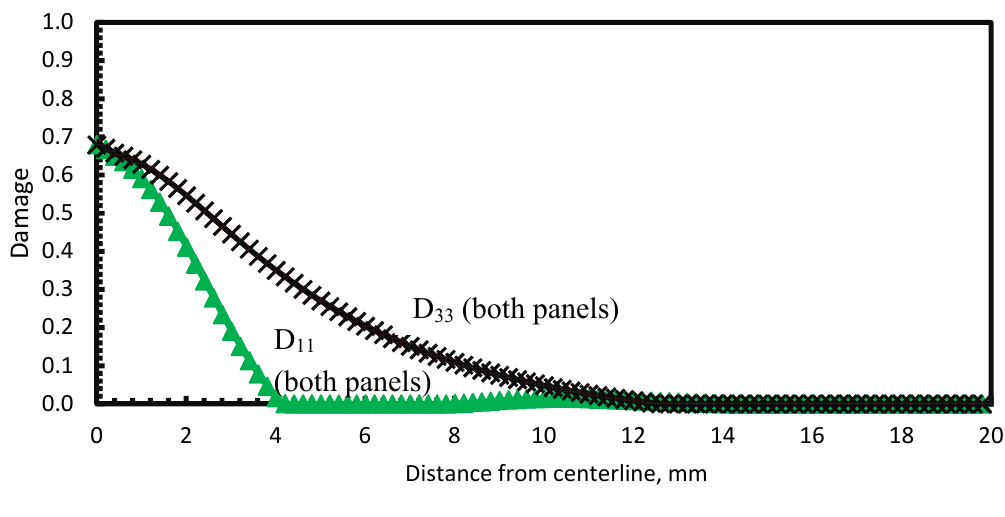
Figure 15. Effect of panel area on Damage variables D at surface S4 for large missile (round end)